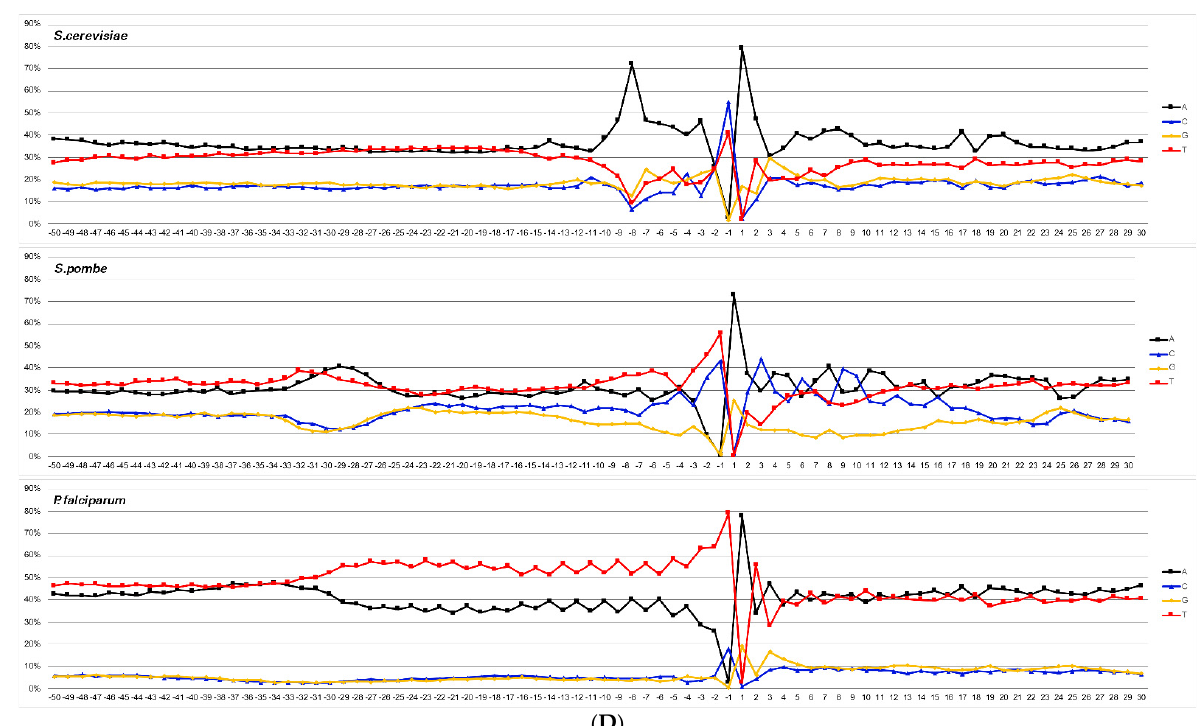
Figure 1. ( A ). Profiles of core promoter sequences as the mononucleotides frequencies of occurrence (in percentages) at each position along the strand, complementary to template for data sets of H. sapiens , M. mulatta, M. musculus , R. norvegicus, C. familiaris , and G. gallus. ( B ). Profiles of core promoter sequences as the mononucleotides frequencies of occurrence (in percentages) at each position along the strand, complementary to template for data sets of D. melanogaster , A. mellifera , D. rerio , and C. elegans. ( C ). Profiles of core promoter sequences as the mononucleotides frequencies of occurrence (in percentages) at each position along the strand, complementary to template for data sets of A. thaliana and Z. mays. ( D ). Profiles of core promoter sequences as the mononucleotides frequencies of occurrence (in percentages) at each position along the strand, complementary to template for data sets of S. cerevisae , S. pombe , and P. falciparum . The frequencies of occurrence of dinucleotides in the core promoter sequences of all fifteen species are shown in Figure S1. The frequencies of occurrence of tetranucleotides TATA and AAAA in the core promoter sequences of all fifteen species are shown in Figure S2.